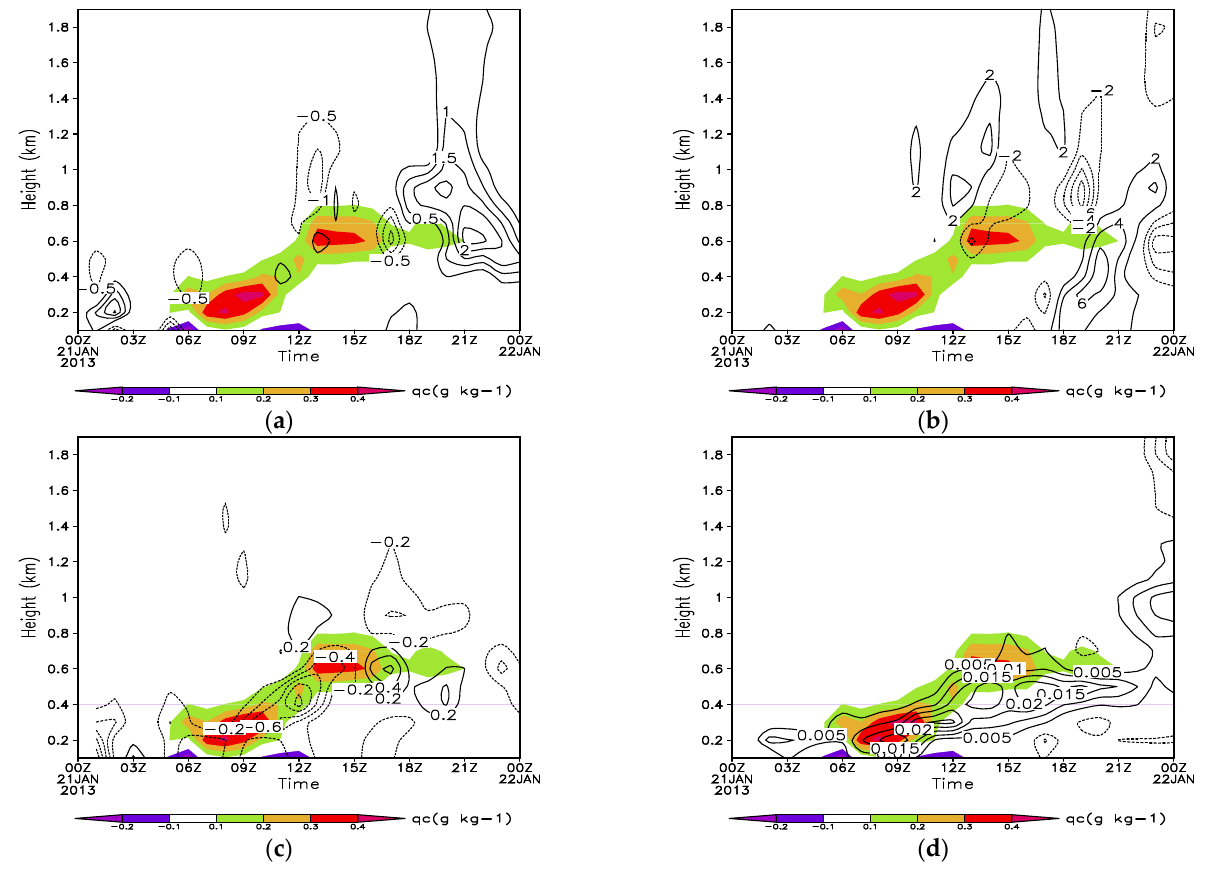
Figure 7. Regional average time-series difference diagram of the contribution of three effects to relative humidity (contour, units: × 10 − 5 s − 1 ) in the sensitivity test of the northern Yellow Sea (Exp.2–Exp.3): ( a ) advection effect in U-direction, ( b ) advection effect in V-direction, ( c ) radiation effect, and ( d ) turbulence effect (shading: difference of cloud water mixing ratio, units: g kg − 1 ).